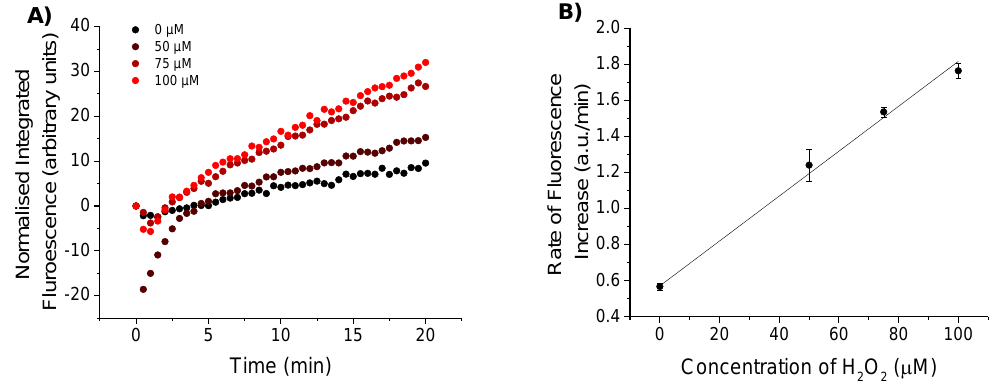
Figure 3. ( A ) Integrated fluorescence intensity from CPF1 using blue excitation with varied peroxide concentration in pH 7.5 buffer; 100 µ M H 2 O 2 shows an increased fluorescent response from the fibre without H 2 O 2 ; ( B ) Slope of integrated fluorescence for increasing concentrations of H 2 O 2 (0, 50, 75 and 100 µ M). Error bars indicate the standard error of the calculated slope.